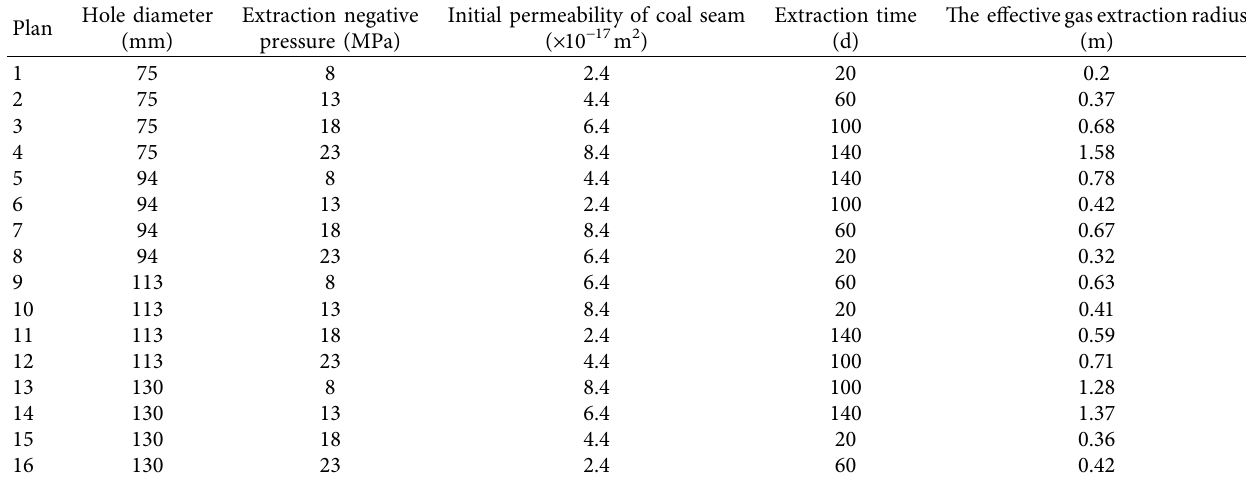
Table 4: Numerical simulation scheme and results of the orthogonal